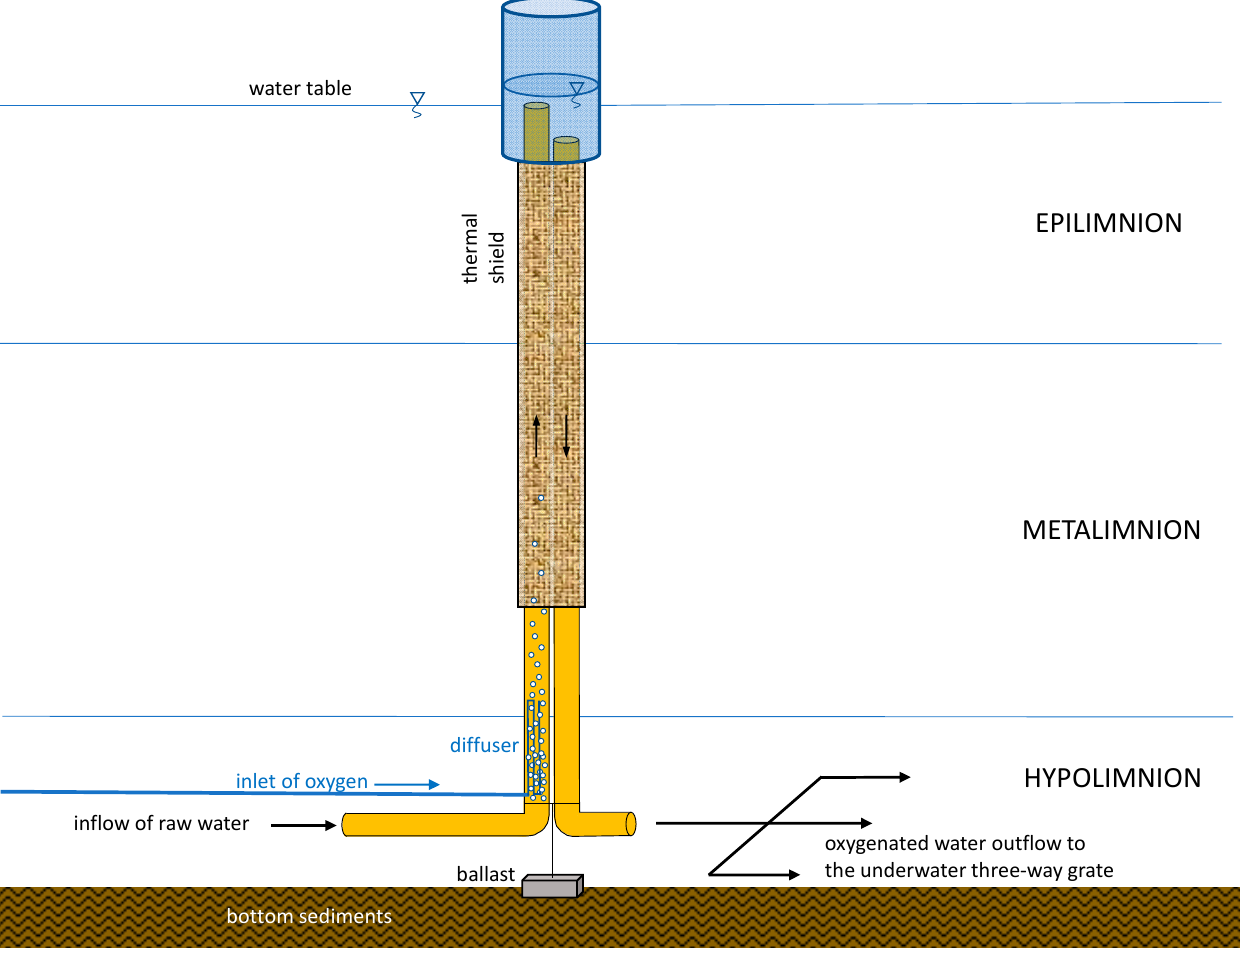
Figure 2. Functional diagram of oxygen reactors used during the restoration of Lake Ł ajskie.